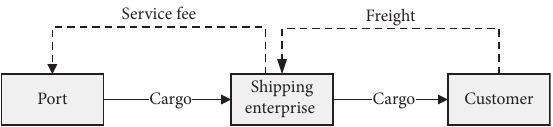
Figure 1: Port and shipping service supply